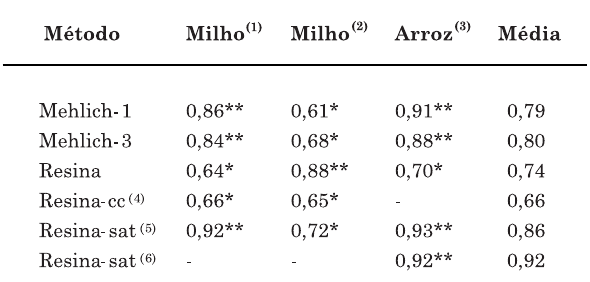
Quadro 4. Coeficiente de determinação de modelo quadrático (R 2 ) entre o fósforo absorvido pelas plantas cultivadas e a quantidade extraída pelos métodos, em solos do RS com diferentes características físicas, químicas, mineralógicas e de